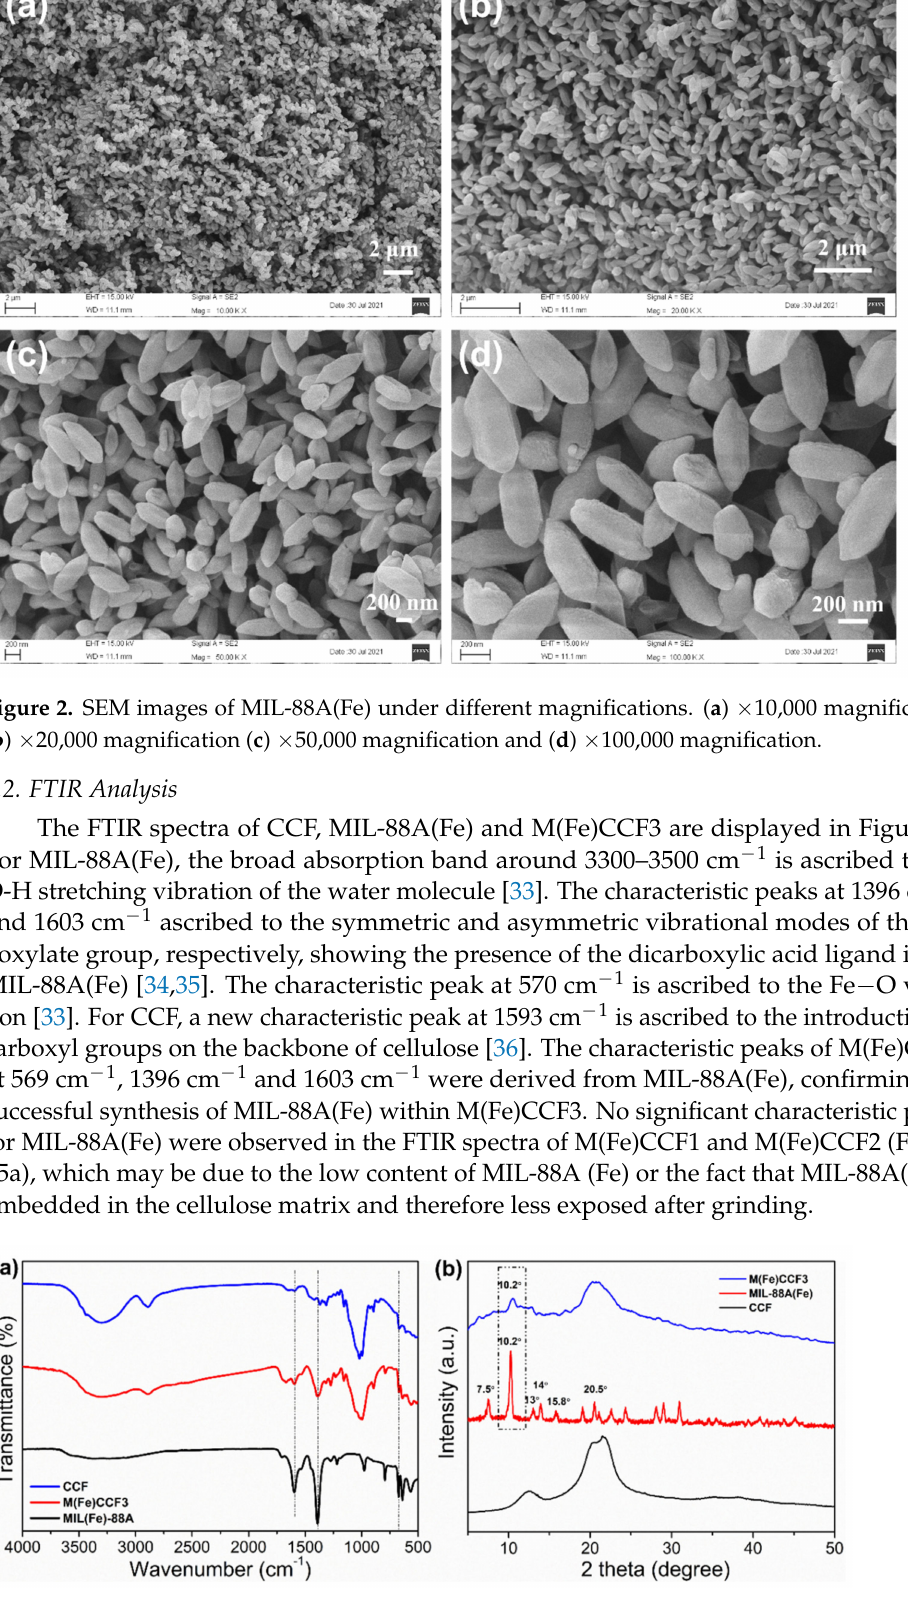
Figure 3. ( a ) FTIR spectra of CCF, MIL-88A(Fe) and M(Fe)CCF3; ( b ) XRD patterns of CCF, MIL- 88A(Fe) and